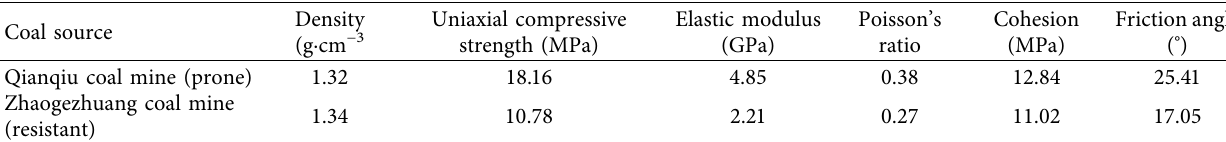
Figure 2: The experimental coal samples: (a) part of the prepared coal sample. (b) The geometric dimension of the coal sample. Table 1: The mechanical and physical properties of coal under a quasistatic